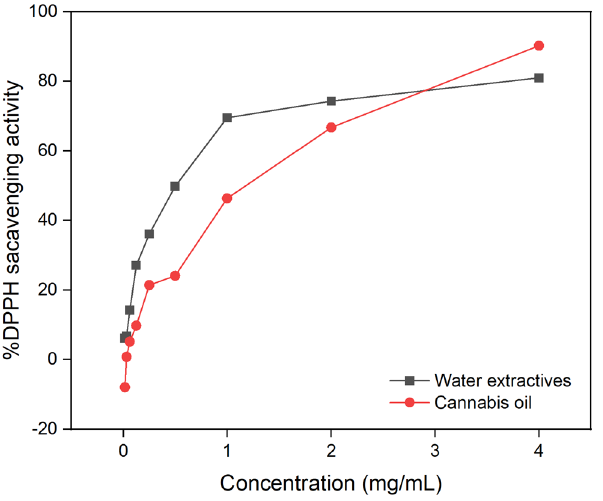
Figure 6. DPPH scavenging activity of water extractive and cannabis